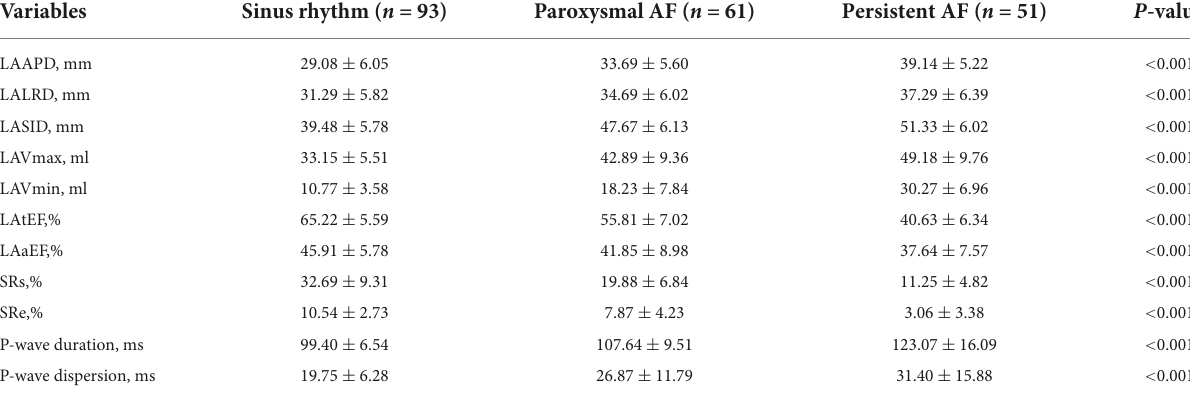
TABLE 2 Indexes of LA remodeling and function in